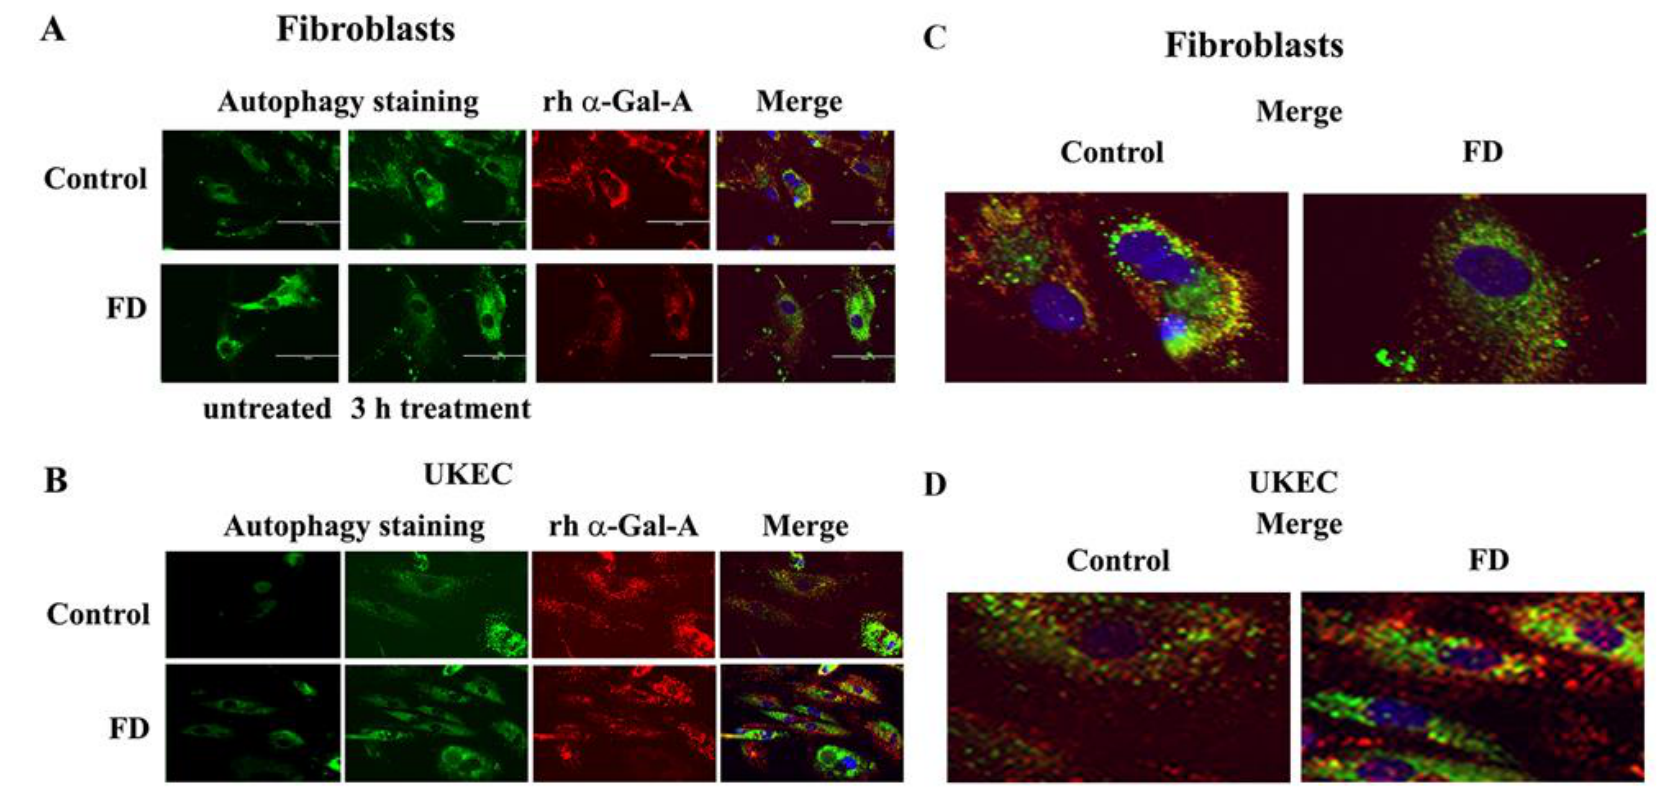
Figure 7. rh-α-Gal-A enhanced autolysosomal compartment. ( A ) Immunofluorescence images of control and FD fibroblasts treated with fluorescence-labeled rh-α-Gal-A (red) and stained with autophagy dye (DALgreen, green). Bar: 100 μm. ( B ). Representative images of control and FD UKEC treated with fluorescence-labeled rh-α-Gal-A (red) and stained with DALgreen (green). ( C , D ). Merge images of control and FD fibroblasts ( C ) and UKEC cells ( D ) treated with fluorescence-labeled rh-α-Gal-A (red) and stained with autophagy dye (DALgreen, green).